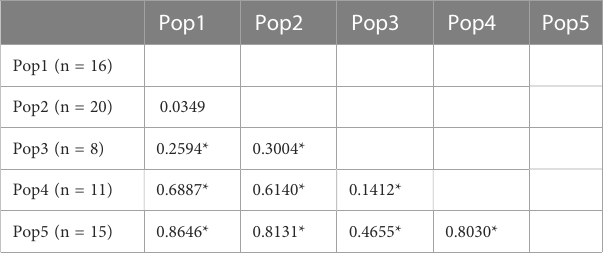
TABLE 2 Pairwise estimates of F ST between fi ve groups in C. okamurae based on COI-5P data. Pop1 Pop3 Pop4